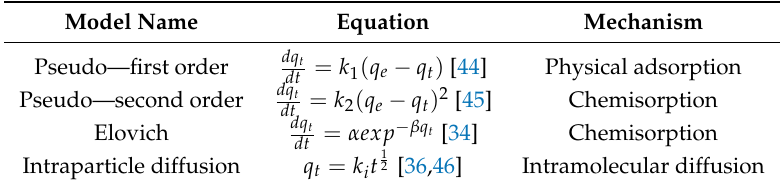
Table 3. Common kinetics models in